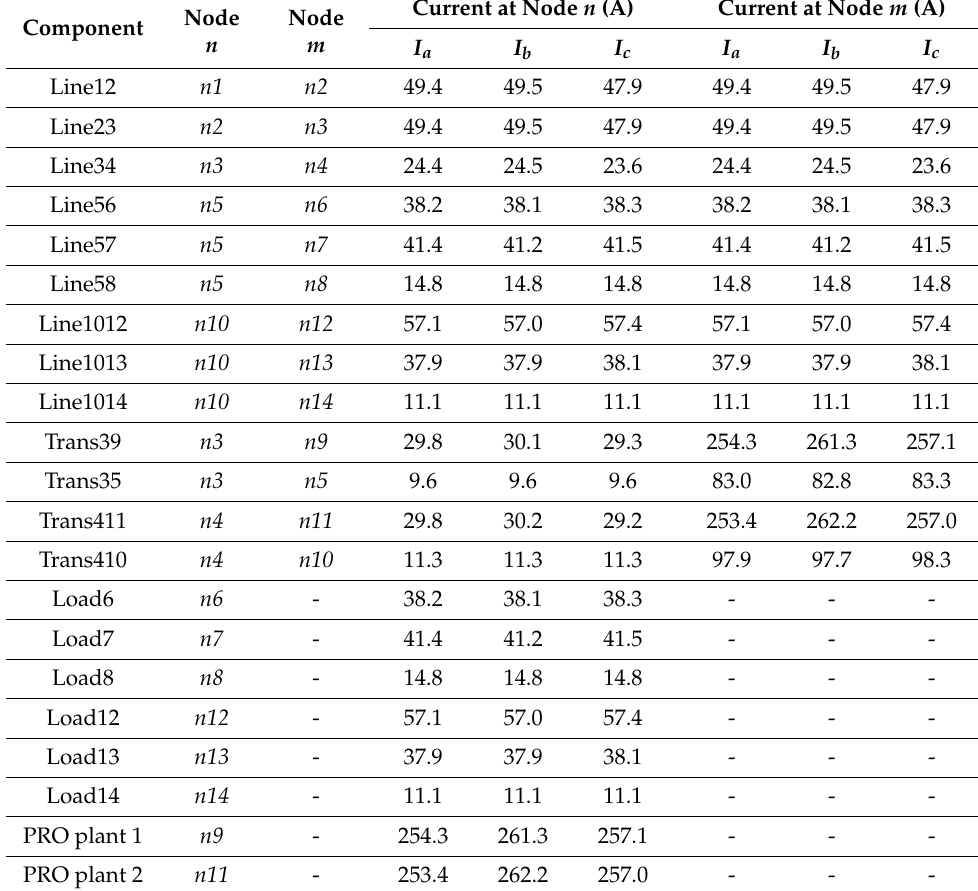
Table 4. Component line current magnitudes with PRO